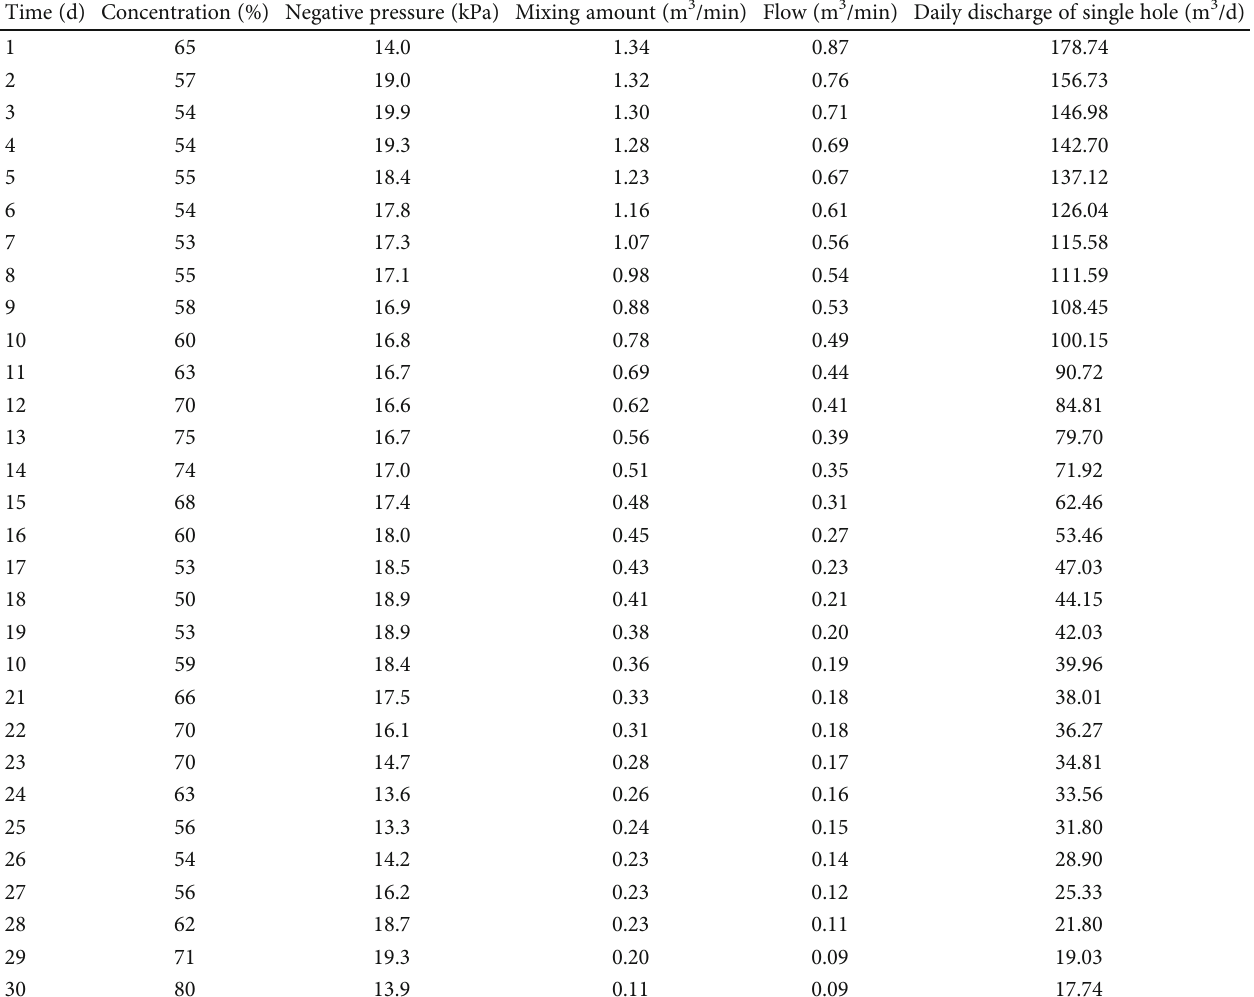
Table 2: Investigation table of reaming borehole drainage